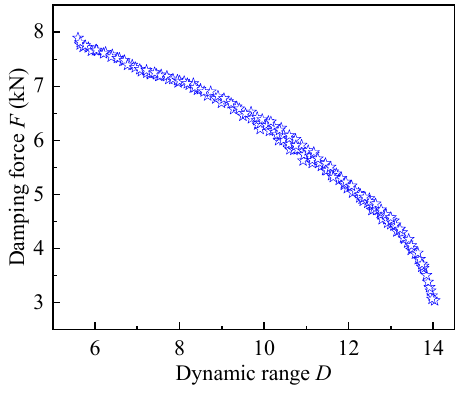
Figure 11. Optimal Pareto front. Table 4. The detailed parameters of the optimal result. Design Variable/mm Initial